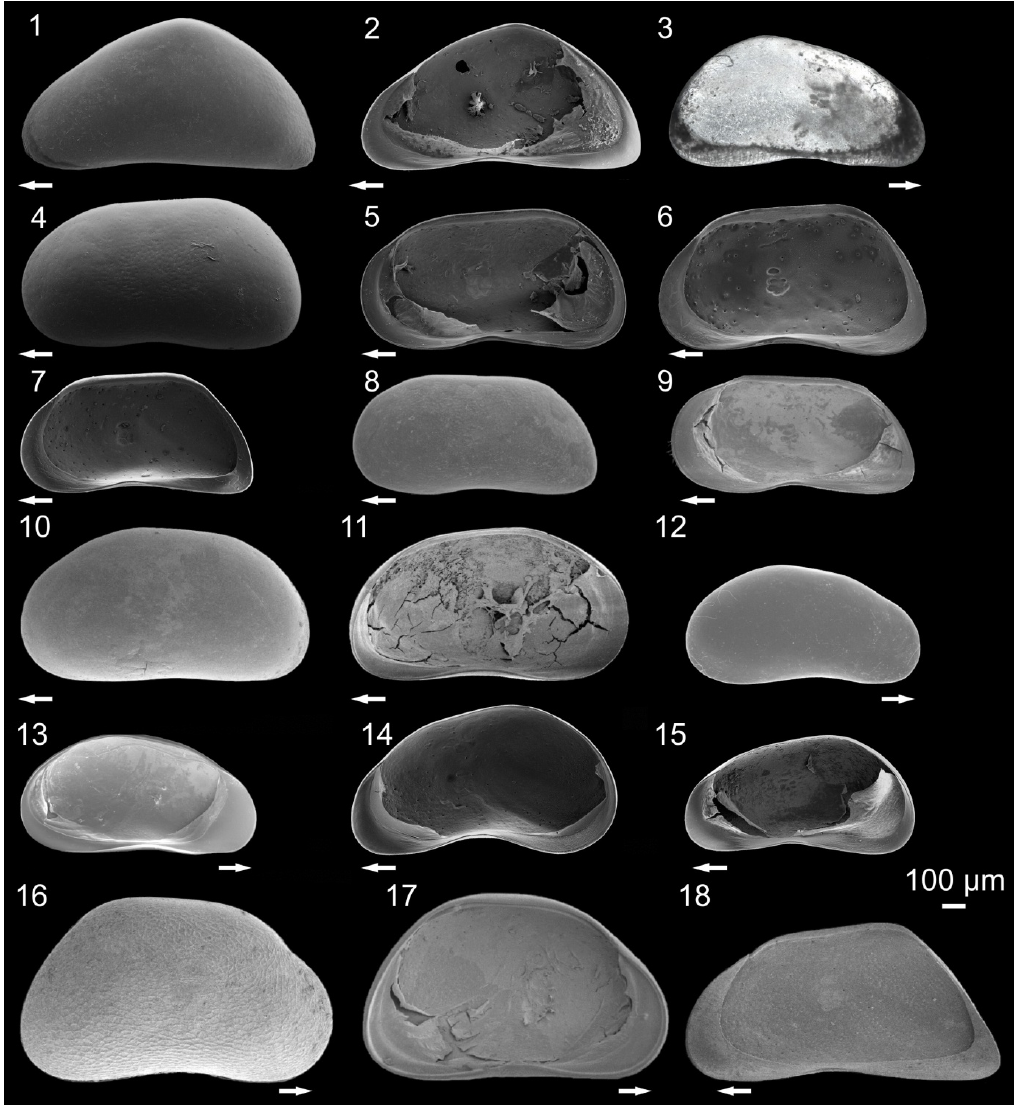
Figure 3. Pictures of ostracodes from Lake Ohrid: Candona triangulata ( 1 ) Left valve (LV), external view, female; C. triangulata ( 2 ) Right valve (RV), internal view, female; Candona litoralis ( 3 ) RV, external view, male; Candona media ( 4 ) LV, external view, female; C. media ( 5 ) RV, internal view, female; Candona trapeziformis ( 6 ) RV, internal view, male; C.trapeziformis ( 7 ) RV, internal view, female; Candona vidua ( 8 ) LV, external view, female; C. vidua ( 9 ) RV, internal view, female; Candona ovalis ( 10 ) LV, external view, female; C. ovalis ( 11 ) LV, internal view, female; Candonopsis kingsleii ( 12 ) RV, external view, male; C. kingsleii ( 13 ) LV, internal view, male; Candona hartmanni ( 14 ) RV, internal view, male; C. hartmanni ( 15 ) RV, internal view, female; Candona ohrida ( 16 ) RV, external view, male; C. ohrida ( 17 ) LV, internal view, male; Candona holmesi ( 18 ) RV, internal view, female. Arrows point to anterior part of valves (modified from